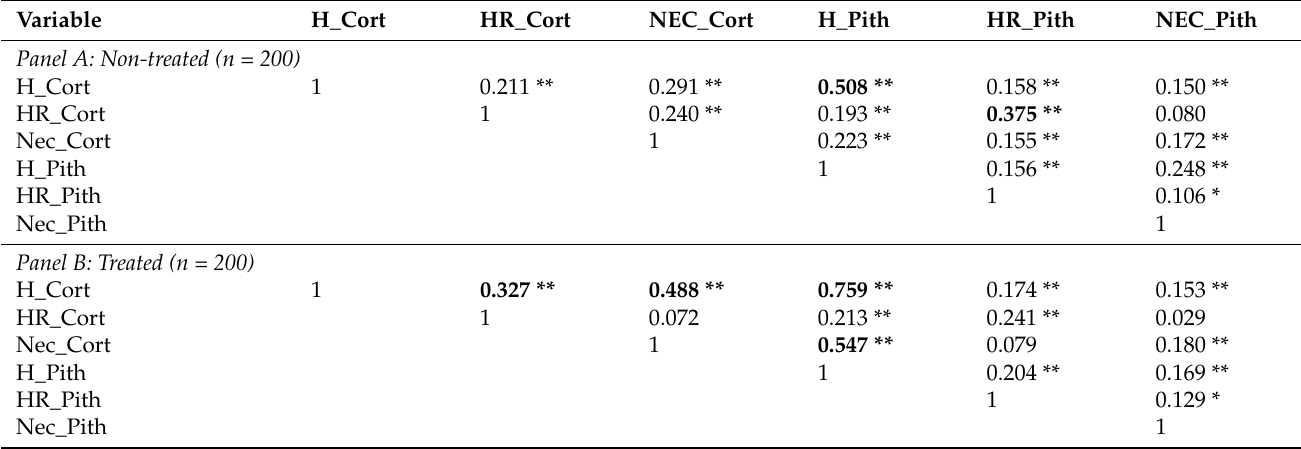
Table 5. Spearman correlation among the examined microscopic